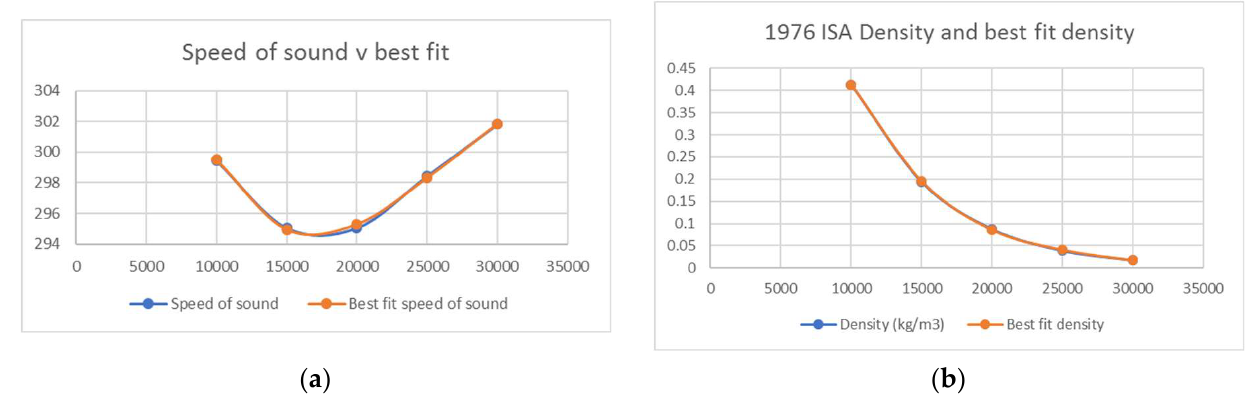
Figure 4. Best fit data for Earth atmosphere [5] used in calculation of capsule drop performance.